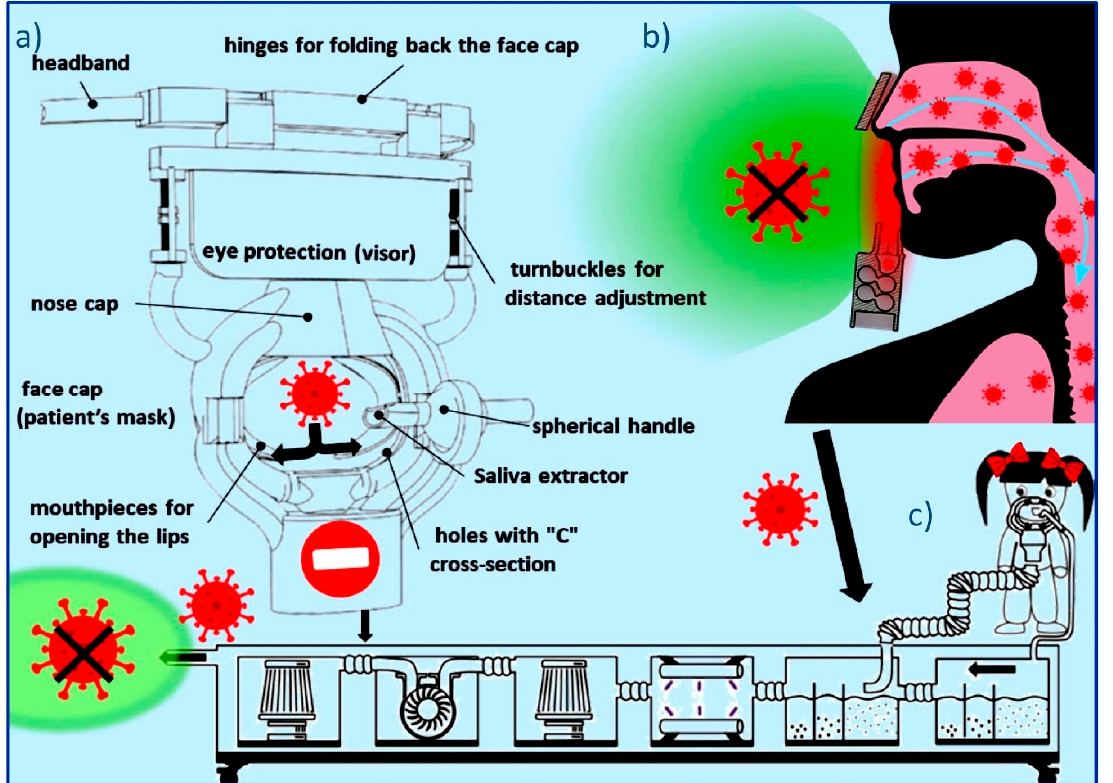
Figure 12. Diagram of the medical staff protection system against the transmission of the SARS-CoV-2 coronavirus: ( a ) diagram of the face shield with a full set of utility functions; ( b ) a source risk elimination scheme; ( c ) a set of devices for inactivation and decontamination of the coronavirus.